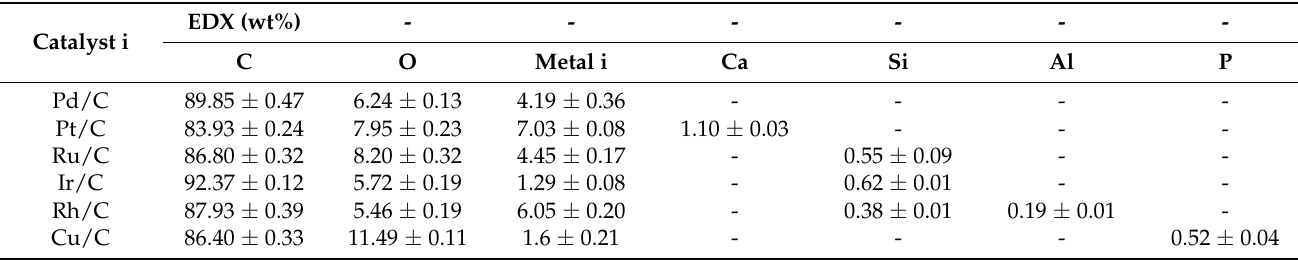
Table 2. Results of the energy-dispersive X-ray (EDX) mapping.